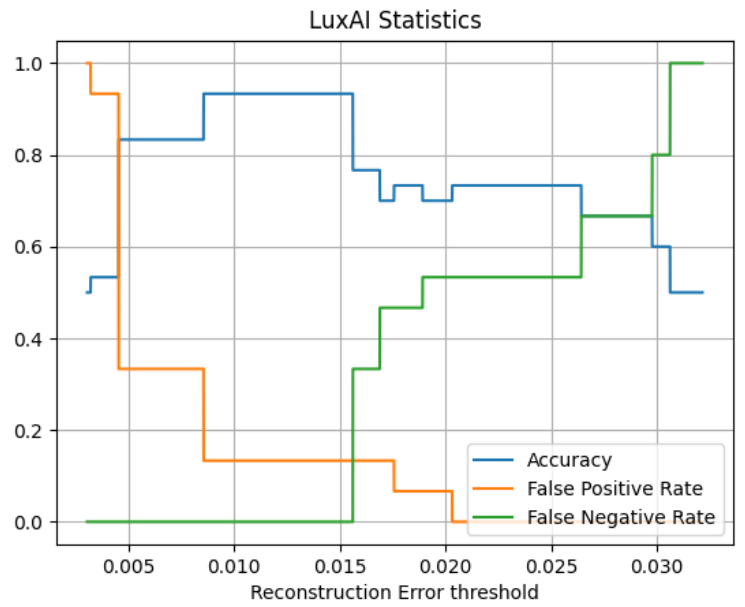
Figure 11. Man-in-the-middle attack